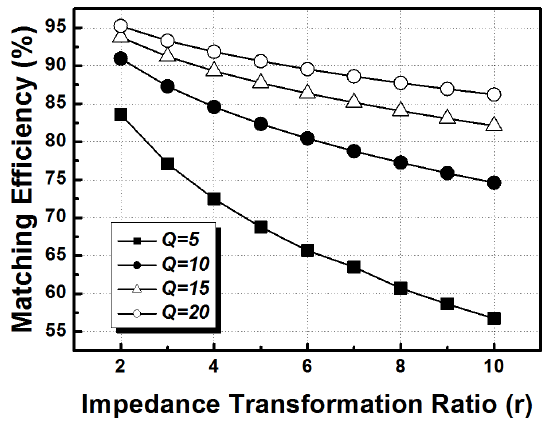
Figure 13. Efficiency of an LC-type matching (differential-in and differential-out). Q represents the quality factor of the inductor used in the network.